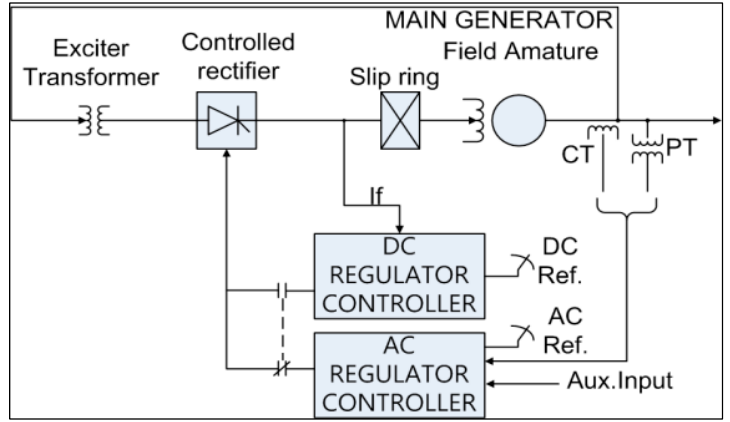
Figure 4. Generator output voltage control method for static excitation system.